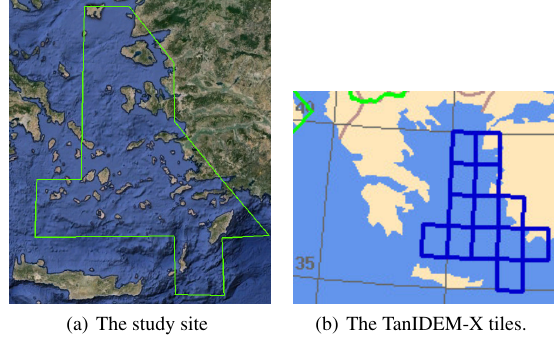
Figure 1. Study site and data